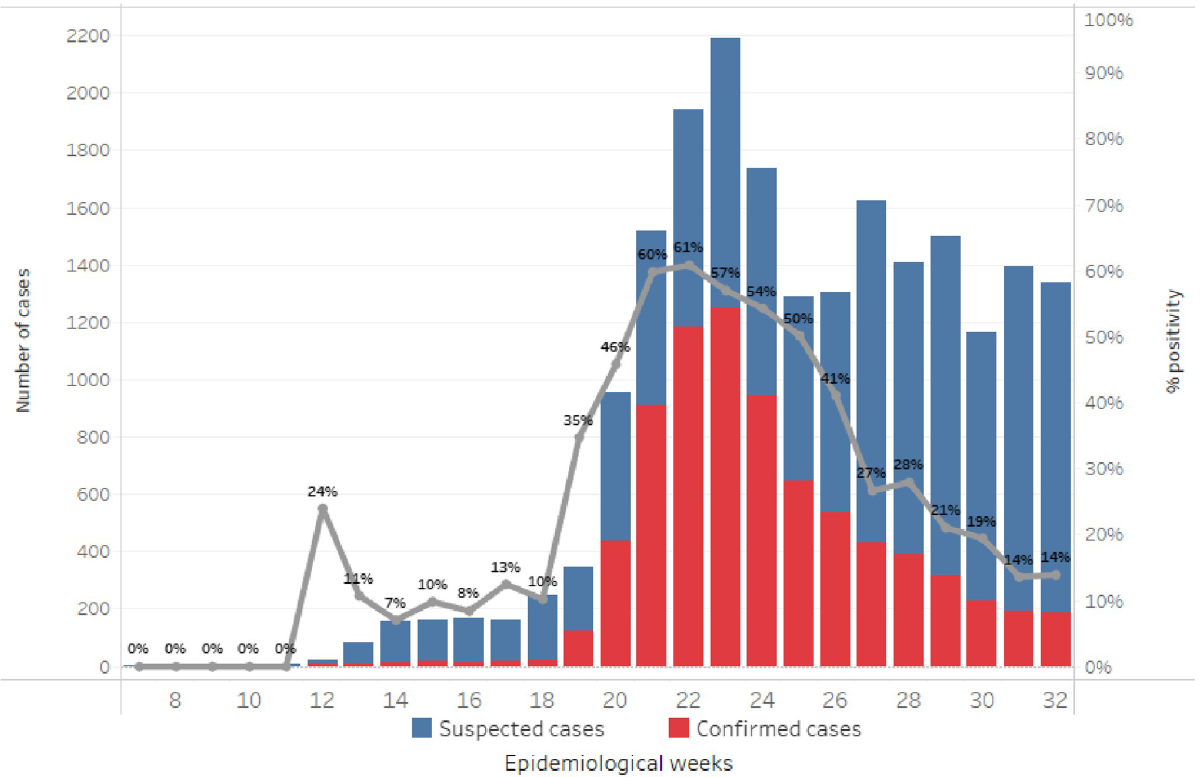
Fig 1. SARS-CoV-2 outbreak by week of onset–Haiti: Number of suspected and confirmed outpatient SARS-CoV-2 cases and percent positivity of tests by epidemiological week from March 18 to August 4, 2020.